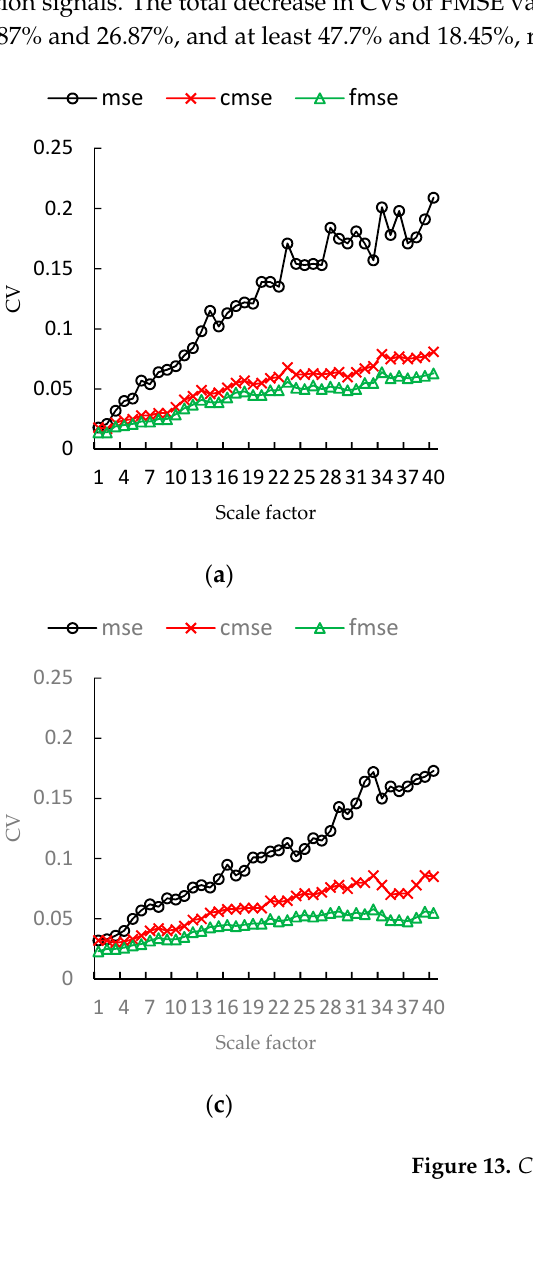
14 of 19 Figure 12. The means of MSE, CMSE, FMSE values on bearing vibration data (1730 rpm, 7 mils). ( a )